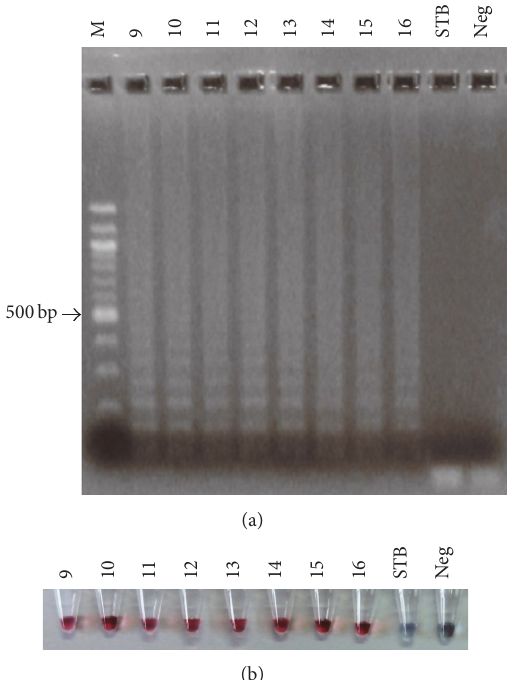
Figure 7: Au-nanoprobe colorimetric assay for MDR-TB detection. (a) Agarose gel showed LAMP products. Lane M: Ladder DNA marker; Lanes 1–8: Mut (MDR-TB), Lane STB: standard strain H37RV, and Lane Neg: negative. (b) Corresponding results recorded visually after salt challenge. A red colour showed the presence of the target, while purple indicated its absence.